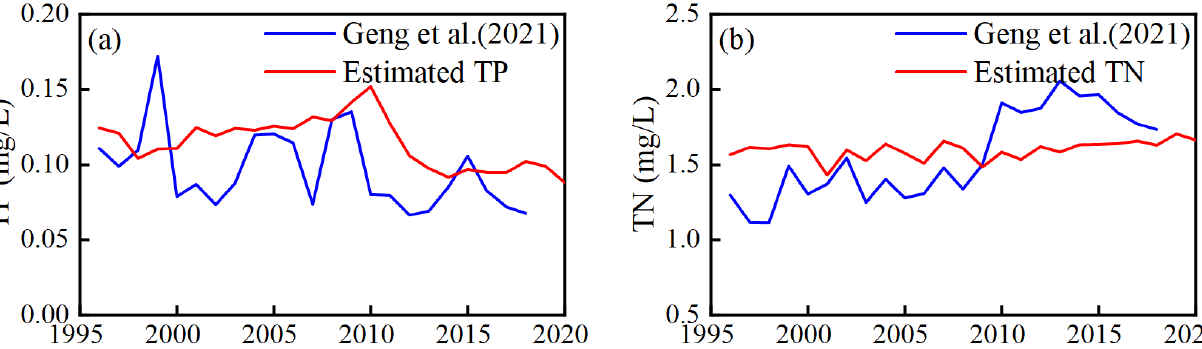
Figure 10. Comparison between remote sensing estimation results and Geng et al.’s results [55]. ( a ) Annual mean of TP content, and ( b ) Annual mean of TN